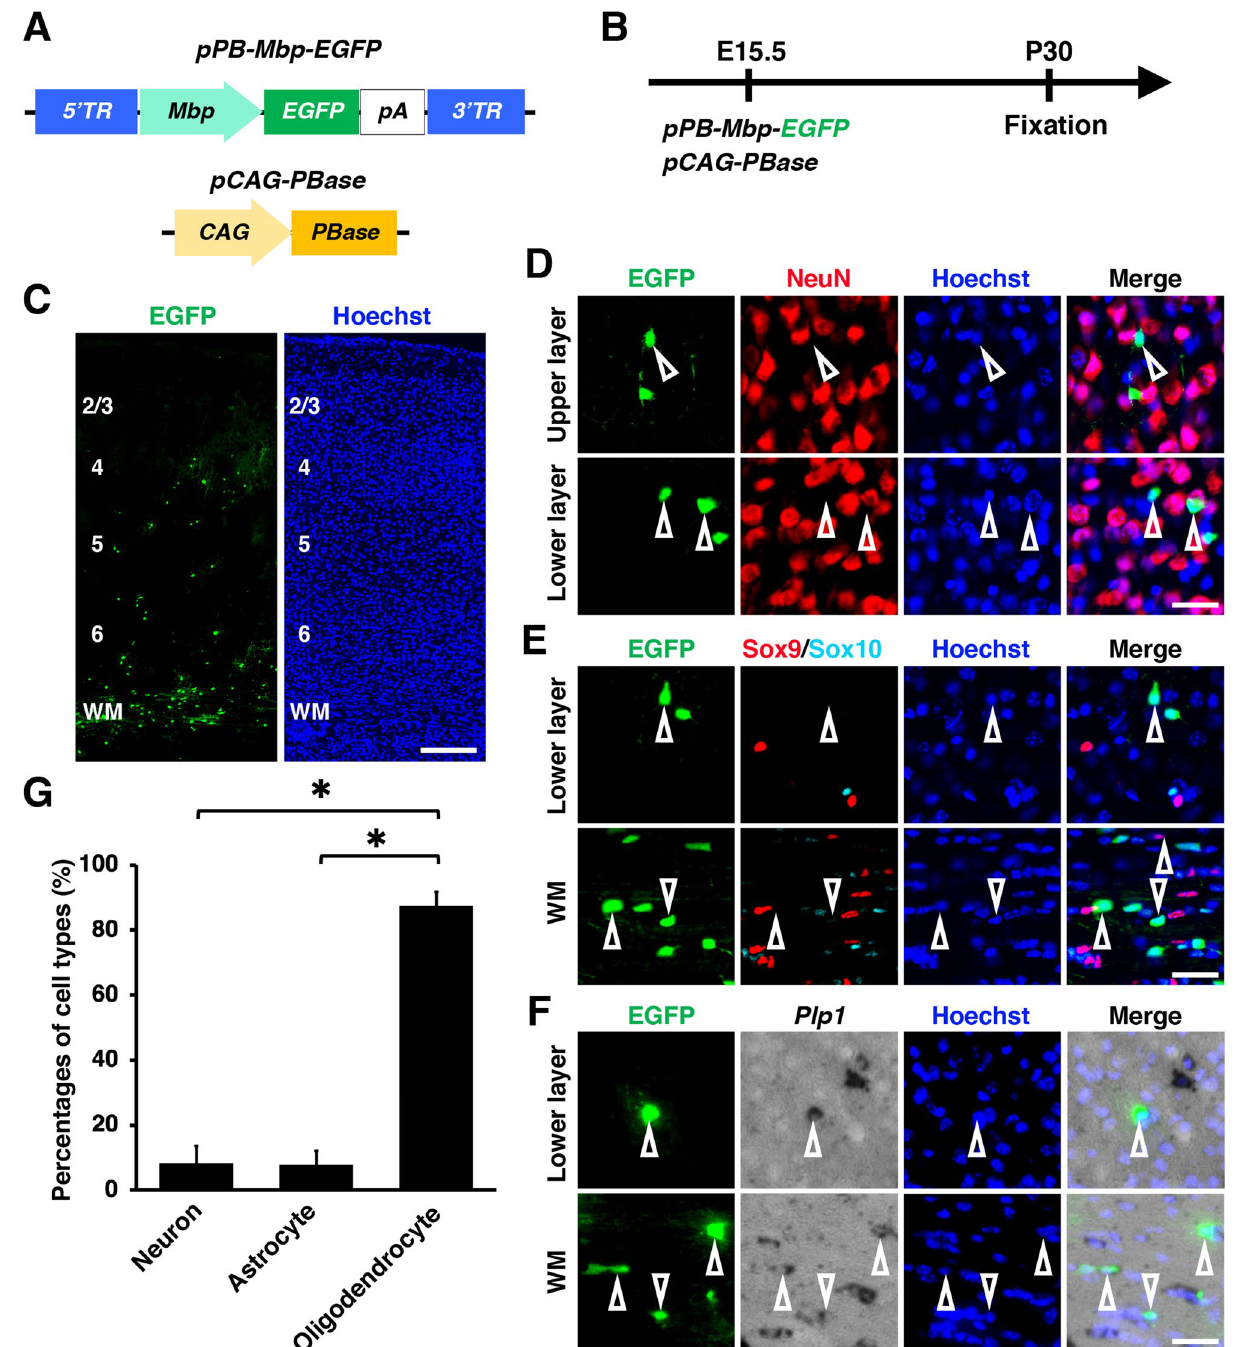
Figure 5. An Mbp promoter induced transgene expression into oligodendrocytes specifically in the mouse cerebrum. ( A ) Schematic of pPB-Mbp-EGFP and pCAG-PBase plasmid. pPB-Mbp-EGFP drives EGFP expression under an Mbp promoter. ( B ) Experimental procedure. pPB-Mbp-EGFP and pCAG-PBase were co-electroporated into the mouse cerebrum at E15.5, and coronal sections were prepared at P30. ( C ) Coronal sections of the electroporated cerebrum. Most EGFP-positive cells were accumulated in the white matter. ( D–G ) Immunohistochemistry for NeuN ( D ), Sox9 and Sox10 ( E ), and in situ hybridization for Plp1 ( F ). Most EGFP- positive cells were positive for Plp1 and negative for NeuN and Sox9 (open arrowheads). ( G ) The percentages of EGFP-positive cells which were also NeuN-positive (neuron), Sox9-positive/Sox10-negative (astrocyte) or Plp1 -positive (oligodendrocyte). This Mbp promoter drove gene expression in oligodendrocytes selectively when combined with the piggyBac system and in utero electroporation. Unpaired Student’s t -test, * P < 0.00005. Error bars represent mean ± SD. The statistical analyses were performed using Microsoft Excel ver. 16.43. Scale bars: 200 μm ( C ), 30 μm ( D-F ). TR, terminal region; WM, white matter. Numbers indicate layers in the cerebral